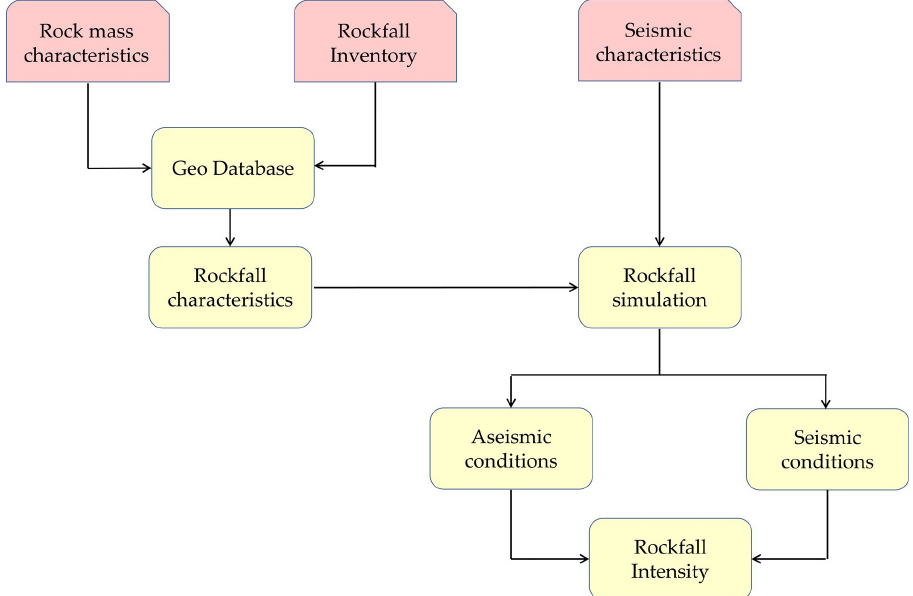
Figure 2. Flow chart of the applied methodology.